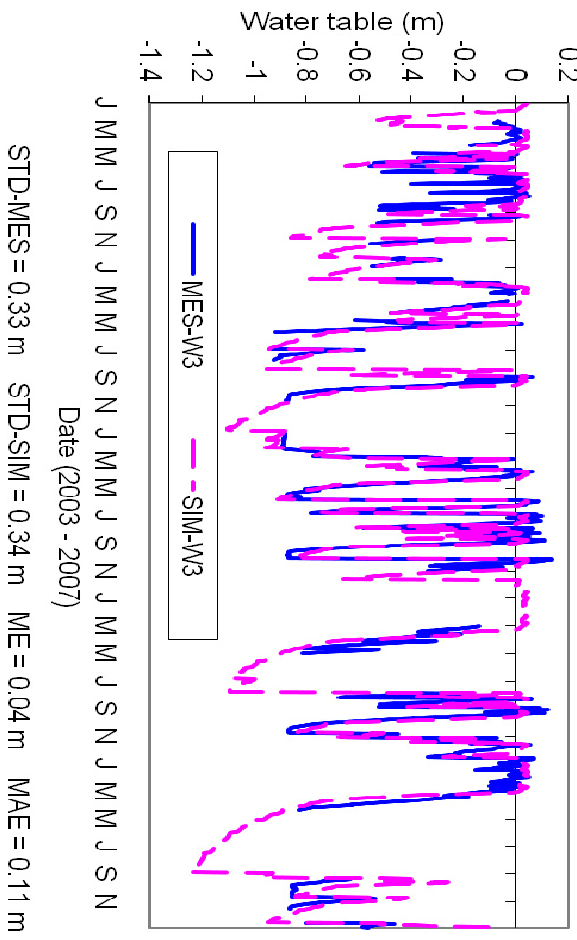
Fig.7c. Temporal variation of groundwater table depth at well W3. Fig. 7c. Temporal variation of groundwater table depth at well This is a shallower well, and the depth was 54cm below the ground surface before March of 2004, 94cm after (Harder et al., 2007).